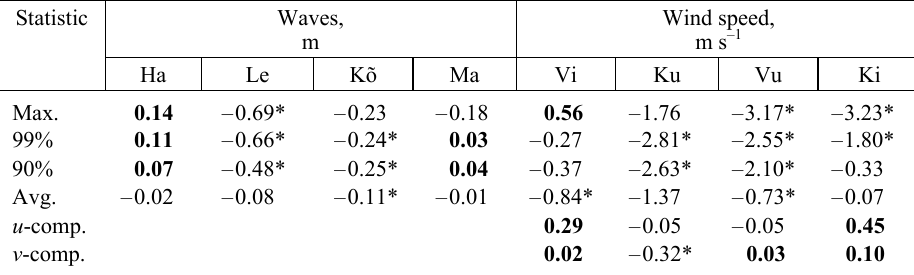
Table 3. Average changes according to linear trendlines calculated from modelled wave time series at the Harilaid Peninsula (Ha), Letipea (Le), Kıiguste (Kı), Matsi (Ma), and wind time series at Vilsandi (Vi), Kunda (Ku), Virtsu (Vu) and Kihnu (Ki) in 1966(cid:150)2011 (see also Figs 6, 7). The values divided by 46 (years) give average annual change rates. Positive trend values are highlighted in bold. Results with significantly differing from zero trend slopes (on p < 0.05 level) are marked with an asterisk Waves,